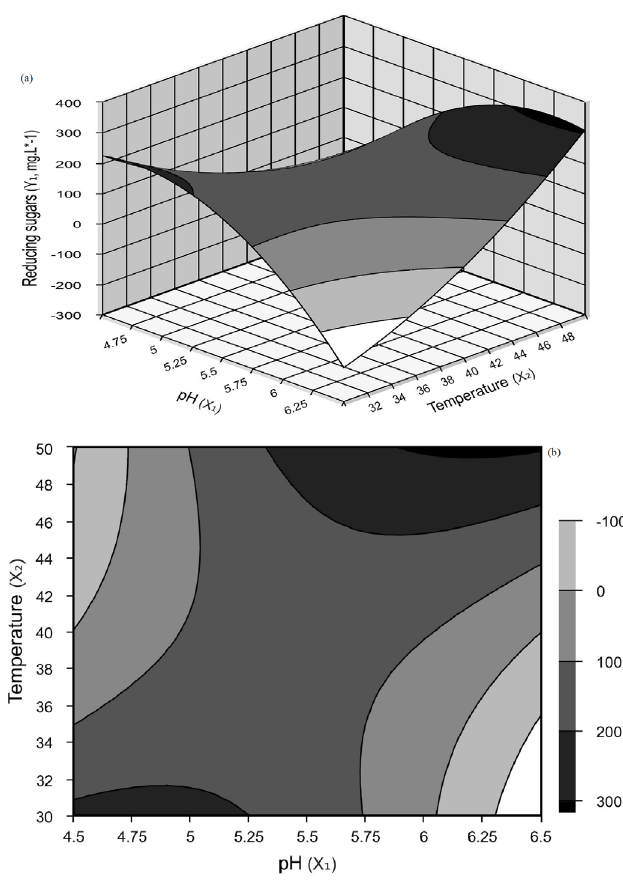
Figure 1. Effect of temperature and pH on the enzymatic hydrolysis of sweet potato flour by C. homilentoma (S-47) strain under submerged culture: (a) response surface and (b) contour